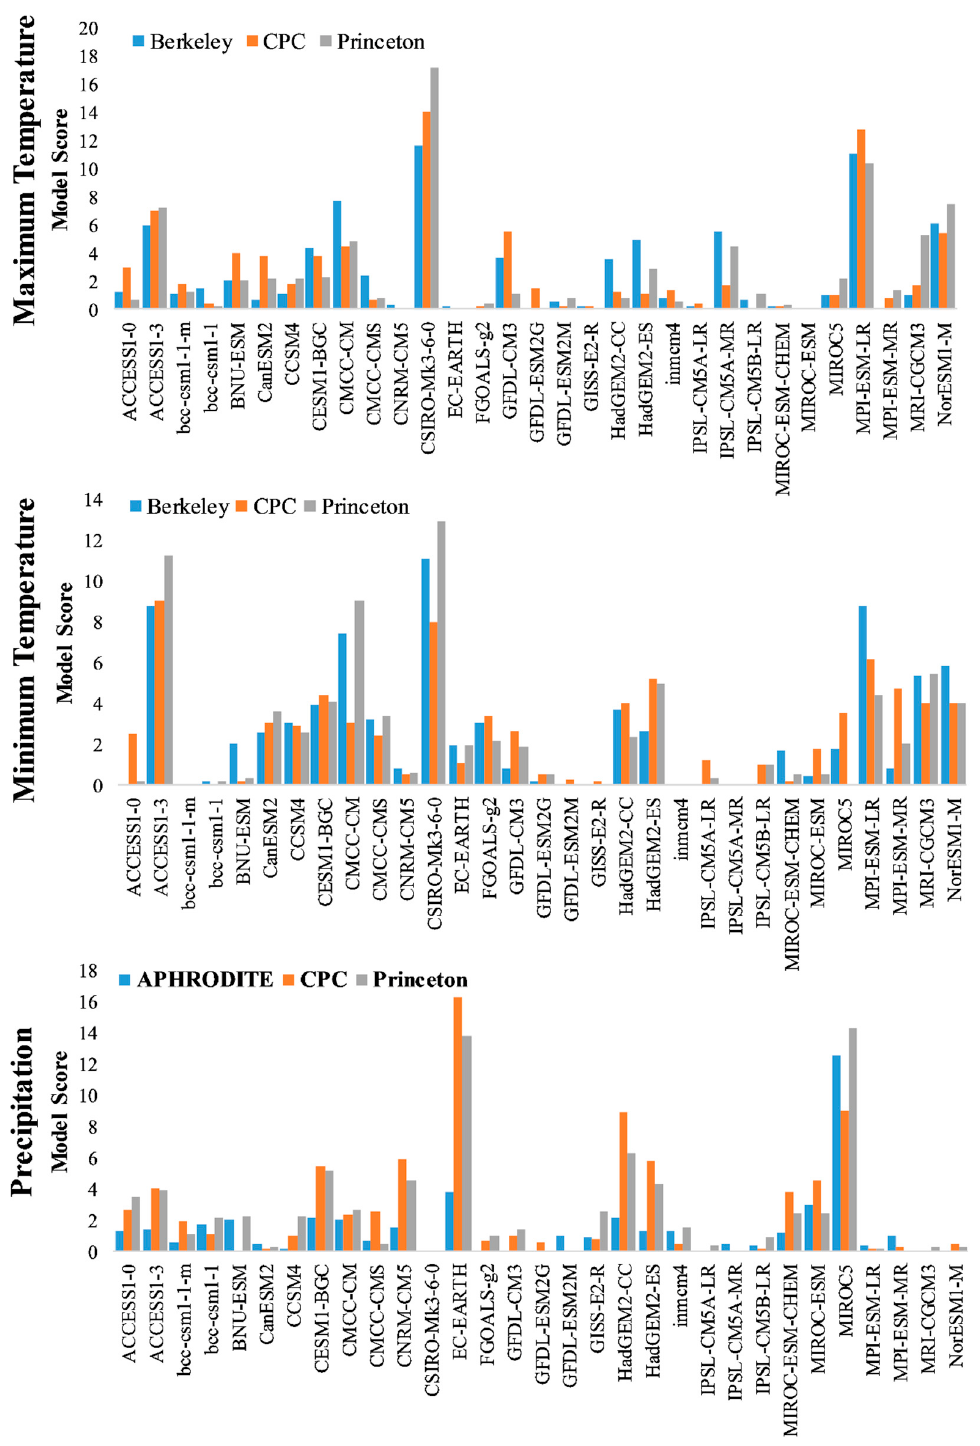
Figure 6. Score estimated for different GCMs in simulating the maximum temperature (upper panel), the minimum temperature (middle panel) and the precipitation (lower panel) for Pakistan.